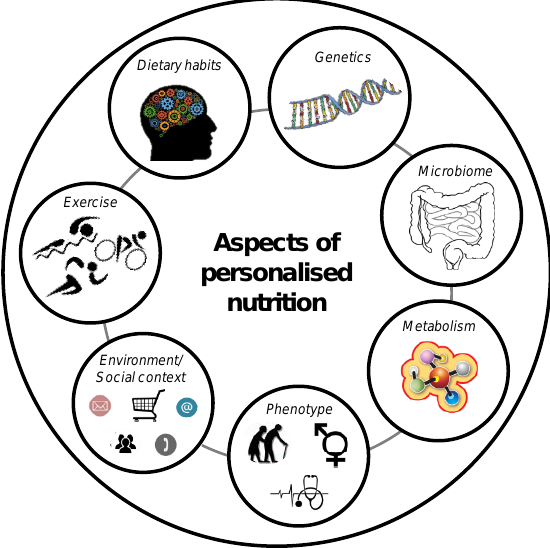
Figure 1. Aspects of personalised nutrition.